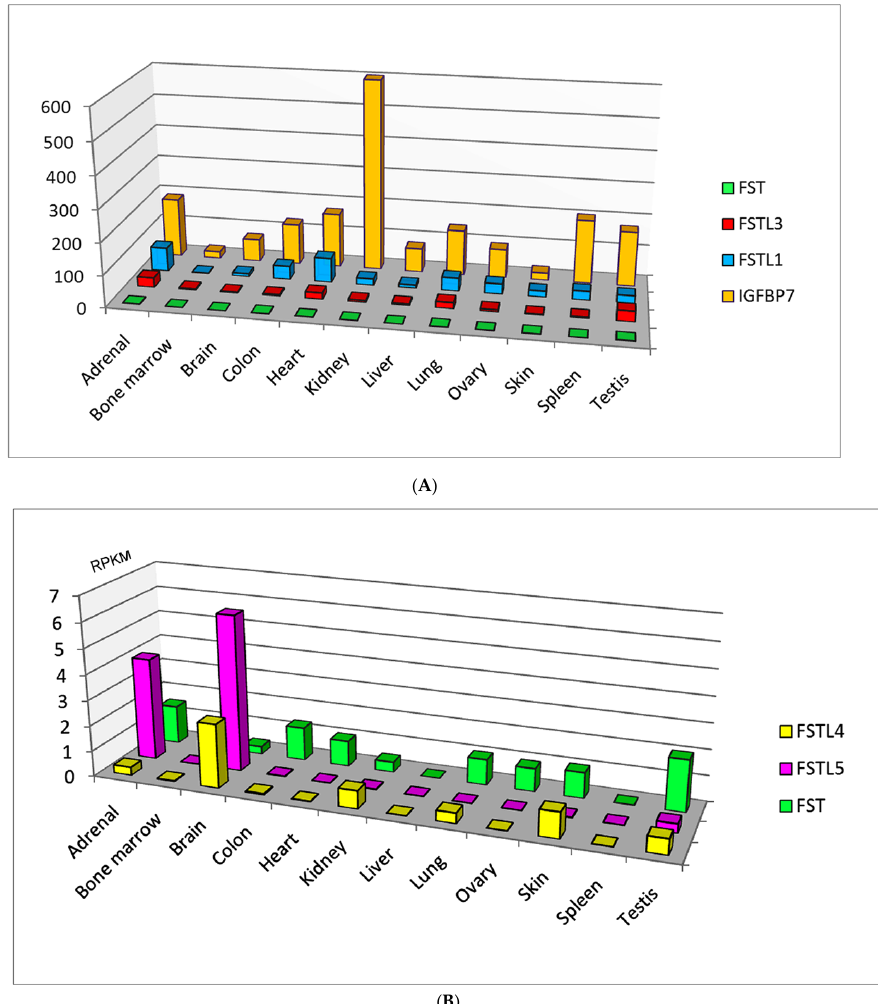
Figure 1. ( A ) Follistatin-like proteins with high tissue-specific expression compared to follistatin (according to the HPA RNA-seq normal tissues project data annotated in the National Center for Biotechnology Information (NCBI) (https://www.ncbi.nlm.nih.gov/, accessed on 1 August 2021)) (RPKM—a normalized unit of transcript expression in reads per kilobase per million of mapped reads). ( B ) Follistatin-like proteins with medium or low tissue-specific expression compared to follistatin (according to the HPA RNA-seq normal tissues project data annotated in the National Center for Biotechnology Information (NCBI) (https://www.ncbi.nlm.nih.gov/, accessed on 1 August 2021)) (RPKM—a normalized unit of transcript expression in reads per kilobase per million of mapped reads).